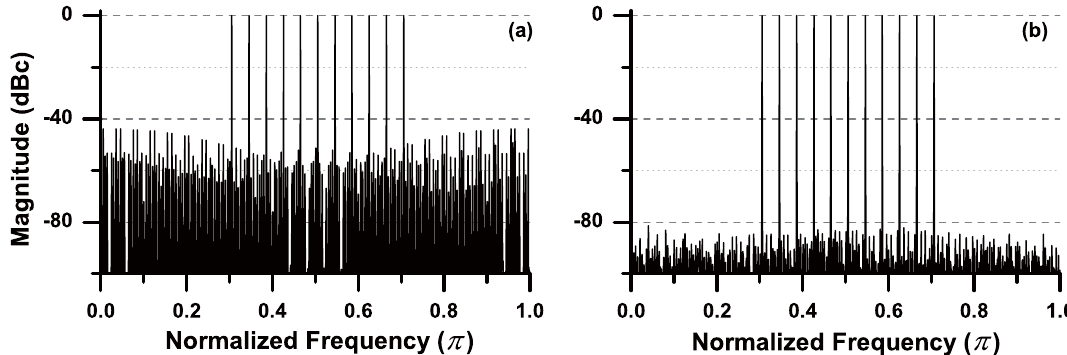
Figure 12. The spectra of 4-TIADC output ( a ) before and ( b ) after calibration for bandpass multi-tone sinusoidal signal input.